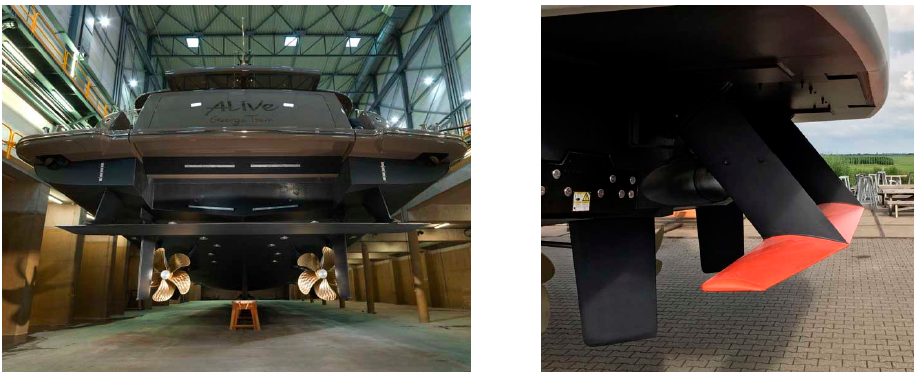
Figure 6. Hull Vane installation reproduced with permission; copyright Hull Vane.